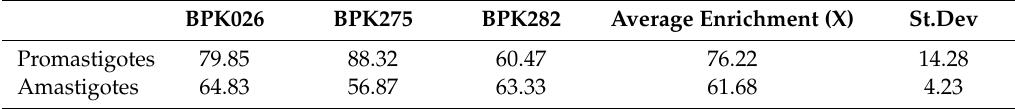
carried out with the NEBNext Microbiome DNA Enrichment Kit